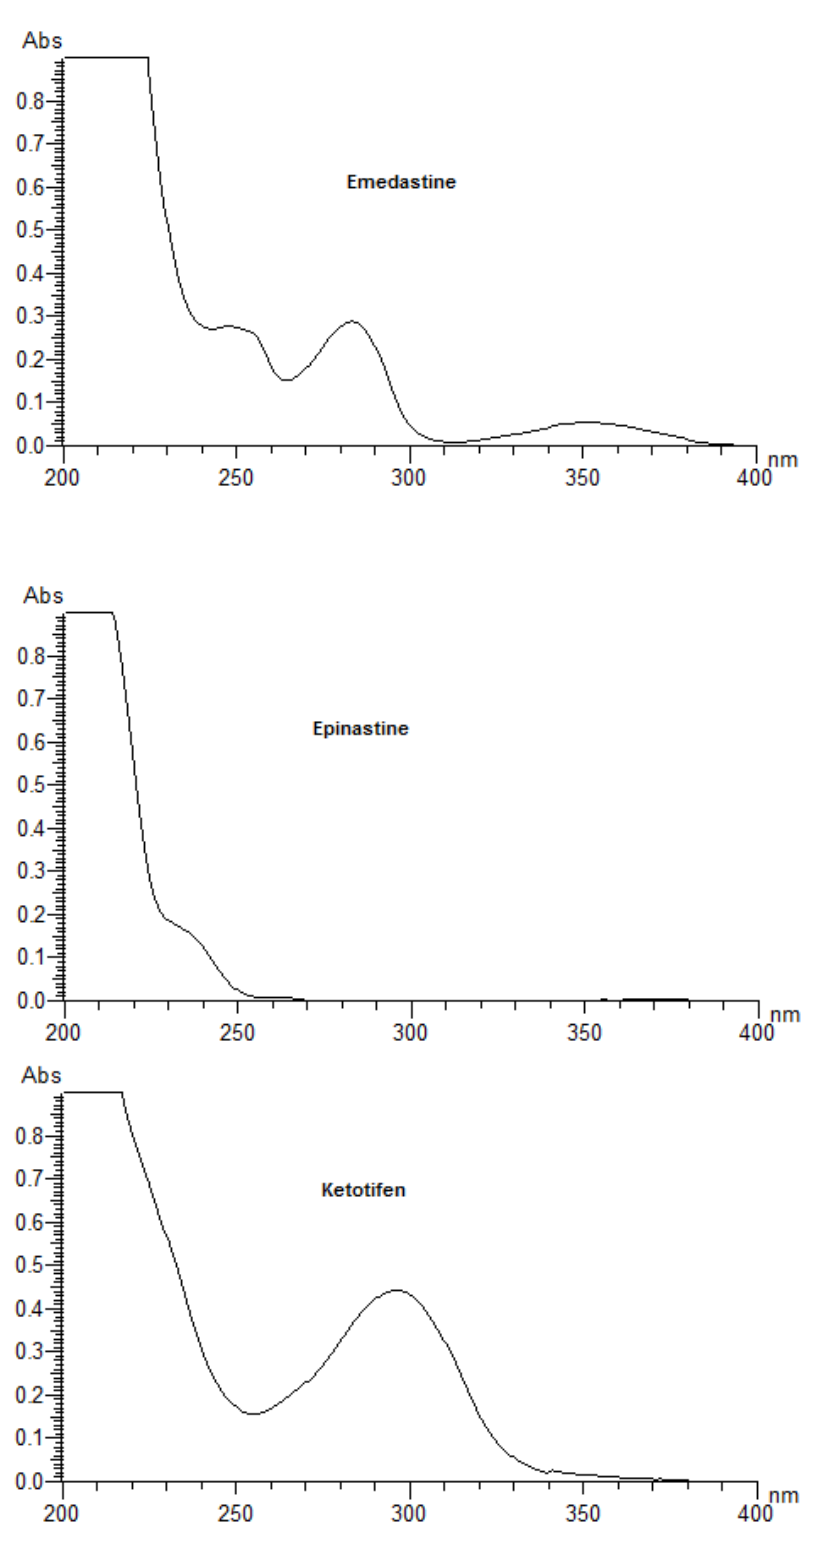
Figure 2. UV spectra of the examined drugs (concentration of 0.01 mg/mL in methanol).